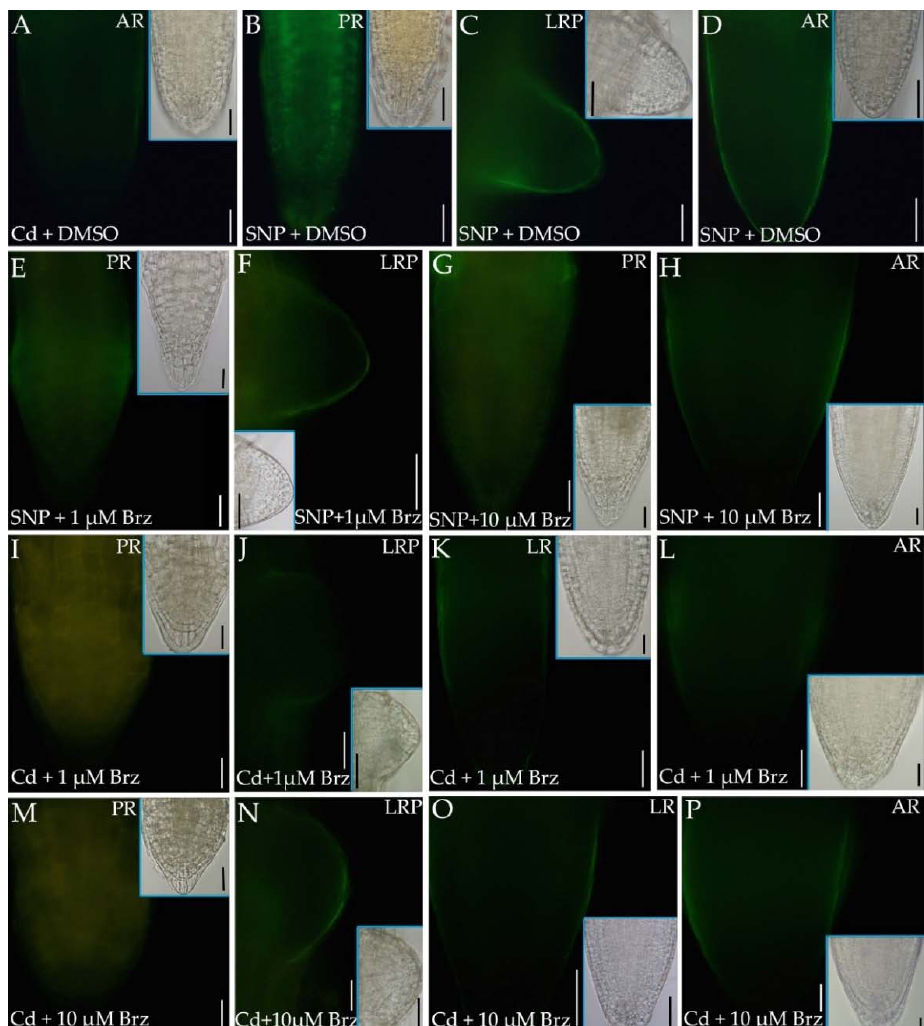
Figure 10. Nitric oxide epifluorescence signal in primary roots (PRs) ( B , E , G , I , M ), lateral root (LR) primordia (LRP, C , F , J , N ), LRs ( K , O ), adventitious roots (ARs) ( A , D , H , L , P ) of Col seedlings incubated with DAF ‐ FM DA after culture for 9 days under continuous darkness followed by 7 days under 16 h light/8 h darkness photoperiod on ½ MS medium (see Section 4) plus either 60 μ M CdSO 4 + DMSO (Cd + DMSO, A ), or 50 μ M SNP + DMSO (SNP + DMSO, B – D ), or 50 μ M SNP + 1 μ M Brz (SNP + 1 μ M Brz, E , F ), or 50 μ M SNP + 10 μ M Brz (SNP + 10 μ M Brz, G , H ), or 60 μ M CdSO 4 + 1 μ M Brz (Cd + 1 μ M Brz, I , L ), or 60 μ M CdSO 4 + 10 μ M Brz (Cd + 10 μ M Brz, M , P ). Inserts are the same apices under white light. Images from the first replicate. Bars = 30 μ m.